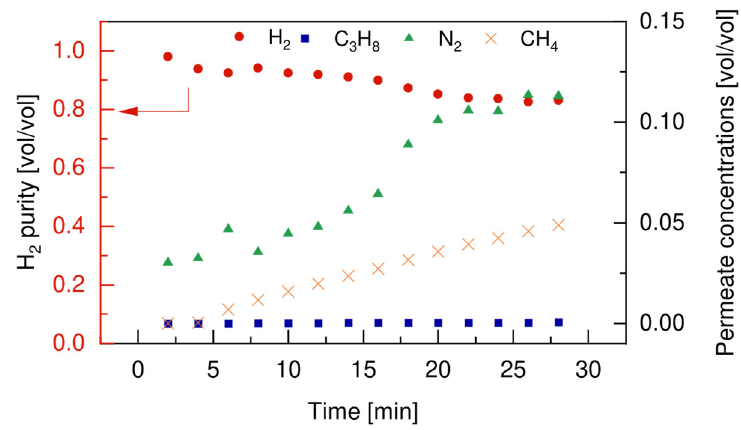
Figure 12. Permeate composition measured at 500 °C, 2 bar, u 0 /u mf of 1.5, and with a feed composi- tion of 30vol% C 3 H 8 -70 vol% N 2 .